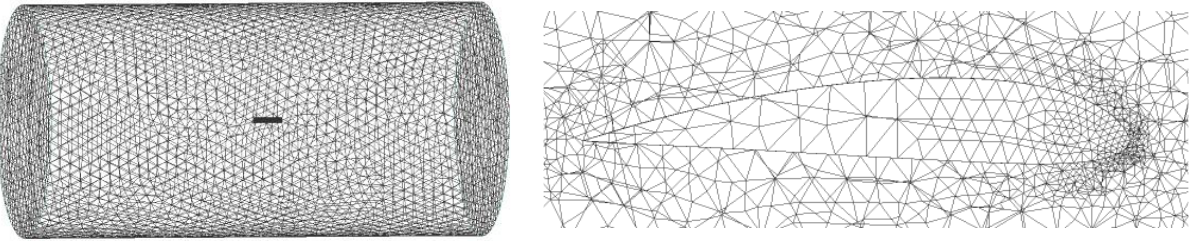
Figure 10. Mesh generation.